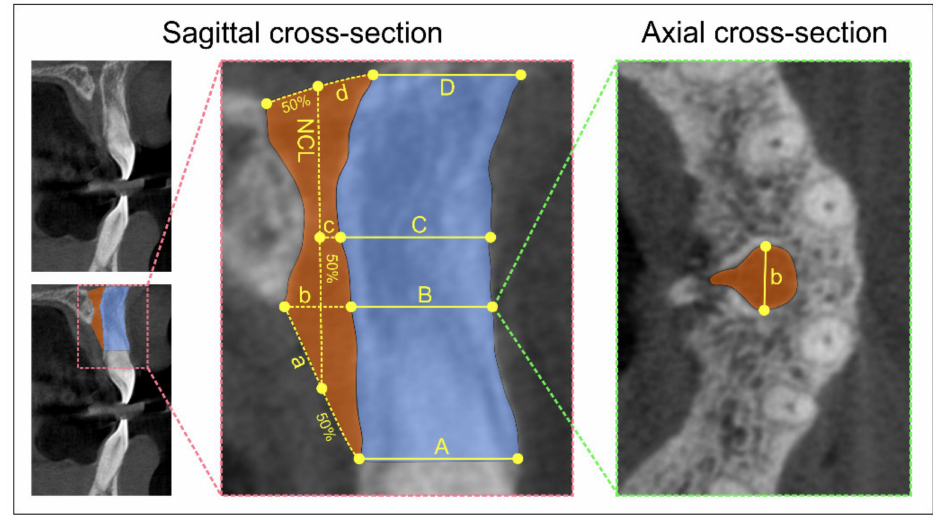
Figure 1. CBCT image and landmarks. Sagittal cross-section—sagittal CBCT slice (left, upper); slice with marked field of interest (left, bellow); selected landmarks for analyses (right)—( a ) A-P diameter of the incisive foramen, ( b ) level for M-L measurement of the incisive foramen, ( c ) mid-length of the NPC, ( d ) A-P diameter of the nasal foramen, NCL (NPC length), ( A ) horizontal dimension of the anterior maxilla from the buccal border of incisive foramen to the cortical layer, ( B ) horizontal dimension of the anterior maxilla from the buccal wall of the nasopalatine canal to the cortical layer using a horizontal line from the palatal border of the incisive foramen, ( C ) horizontal dimension of the anterior maxilla from the buccal border at the midpoint level of NCL to the cortical layer, ( D ) horizontal dimension of the anterior maxilla from the buccal border of nasal foramen to the cortical layer; axial cross-section—( b ) M-L diameter of the incisive foramen.